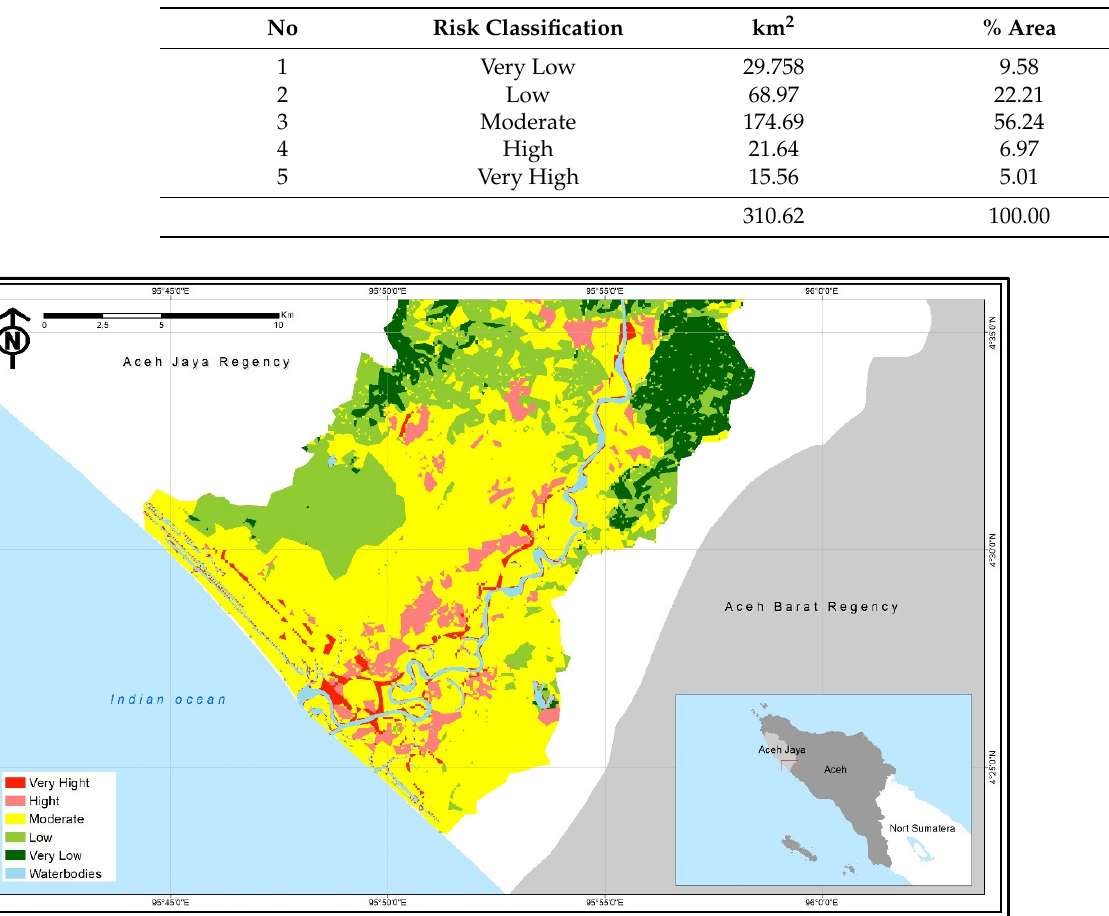
Table 7. Flood risk class based on different slopes of Krueng Teunom watershed and its coverage area.